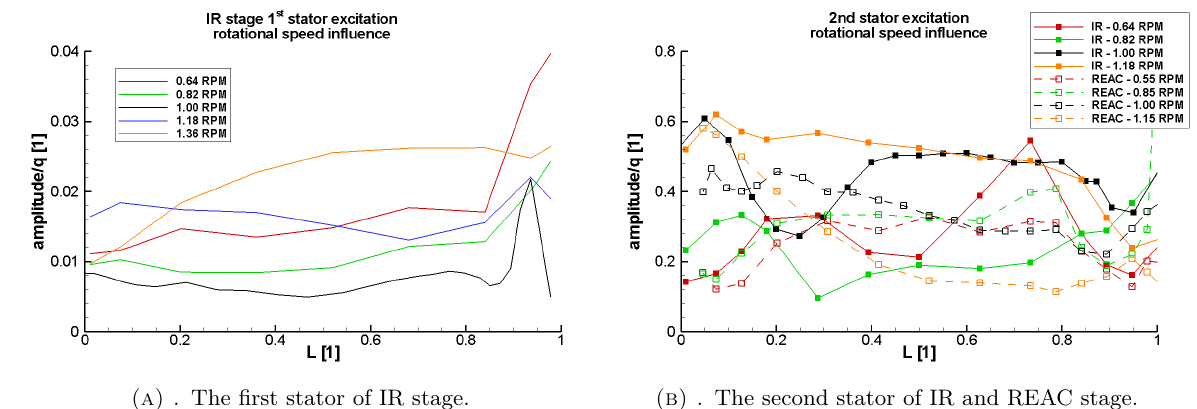
Figure 6. Influence of rotational speed on stators excitation.